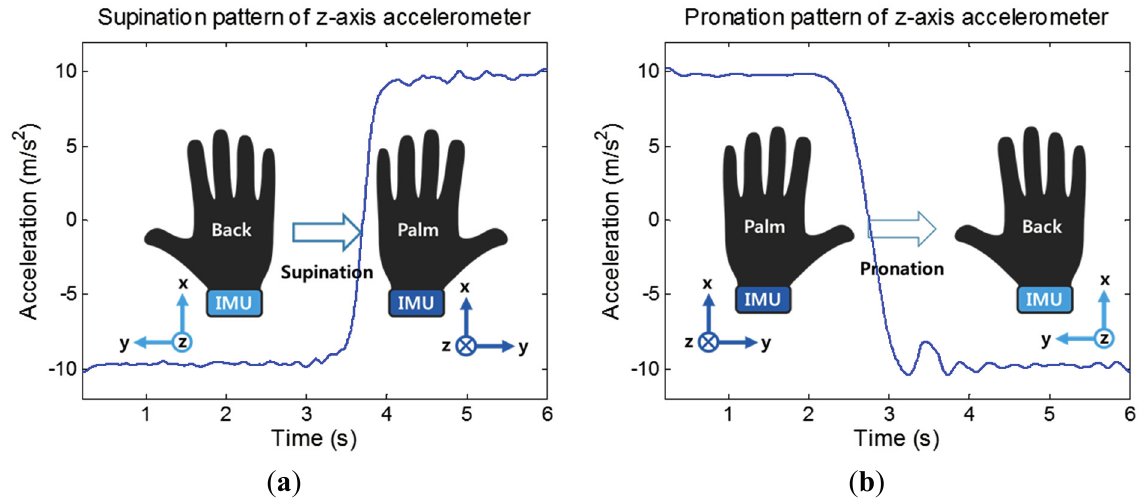
Figure 5. Z-axis accelerometer readings when subject’s elbow supination/pronation movement occur. ( a ) Supination ( b )